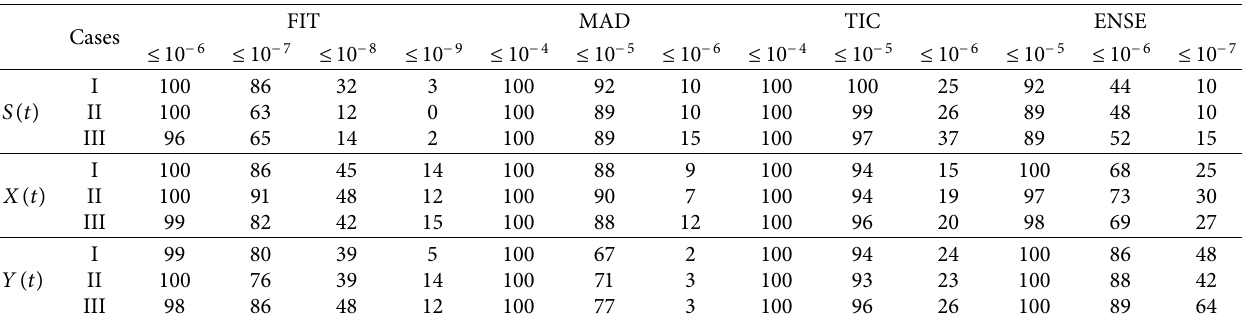
. (b) Convergence of 2 . 2